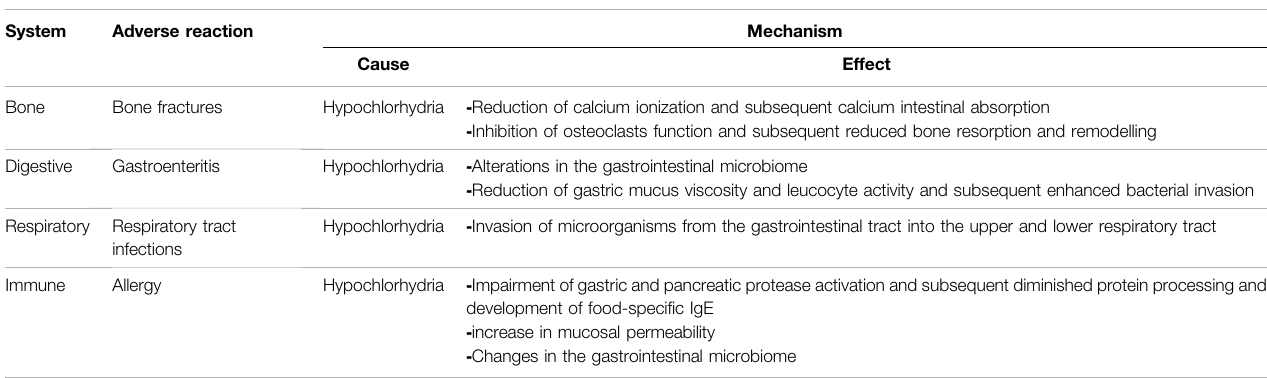
TABLE 2 | Main pathogenic mechanisms hypothesized for PPI-related adverse reactions in